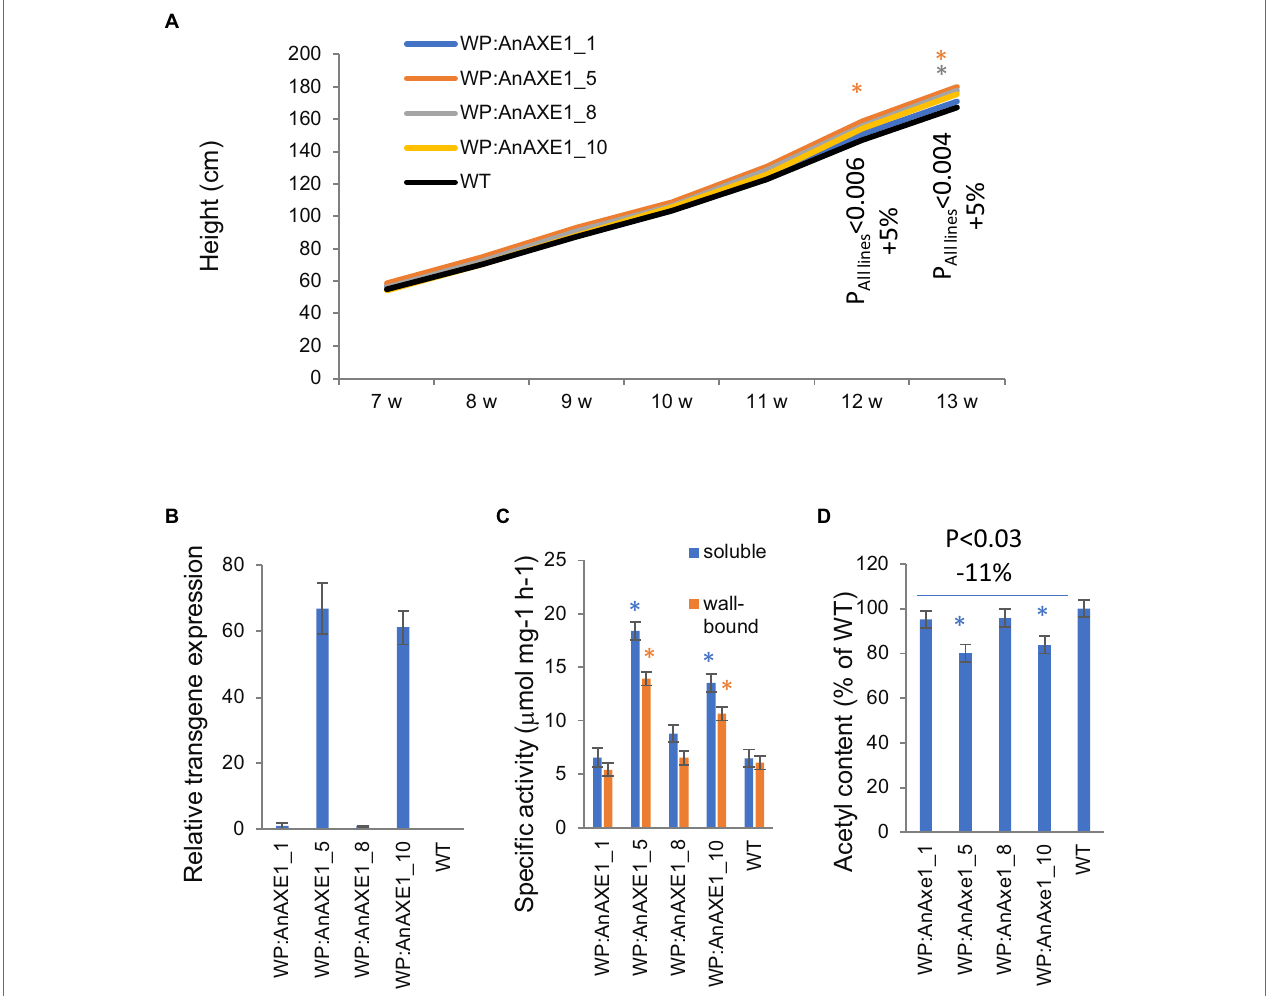
FIGURE 1 | Phenotype of transgenic aspen grown in the greenhouse expressing wood-promoter driven AnAXE1 . (A) Height growth. Means for 10 trees per line. SE varied between 1.4 and 3.1% of the means (not shown for clarity). The values of p indicate the significance of differences between all the transgenic lines and wild-type (WT) plants (post-ANOVA contrast analysis). (B) Transgene expression in developing wood. Means ± SE and N = 4 biological replicates. Values are relative to those of the most weakly expressing line (8). No transcripts were detected in WT plants. (C) Specific acetyl esterase activity in soluble and wall-bound protein fractions extracted from developing wood of transgenic and WT plants. Means ± SE from three independent experiments. (D) Acetyl content of the wood of transgenic and WT plants. Means ± SE of three biological replicates. Significant differences according to ANOVA followed by Dunnett’s test ( p < 5%) are indicated by